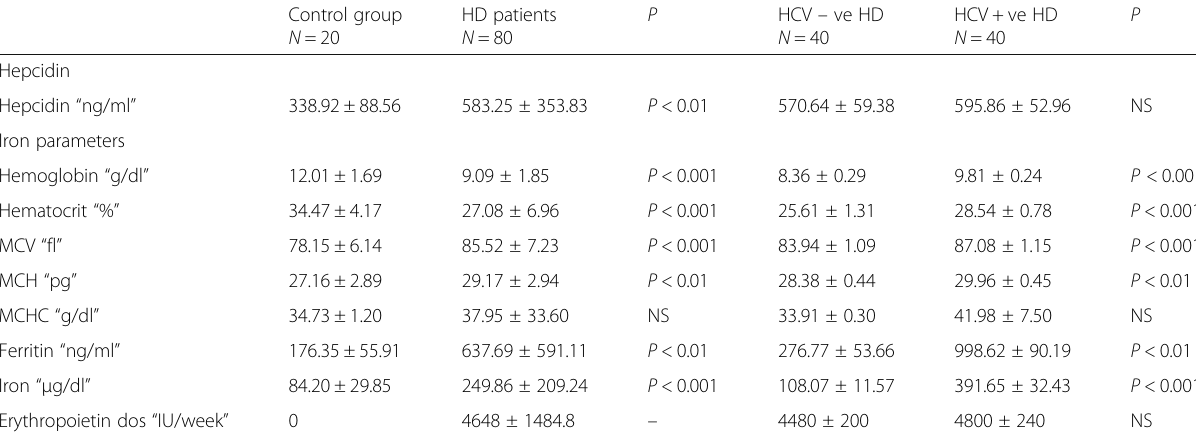
Table 2 Hepcidin and iron status markers of the investigated groups